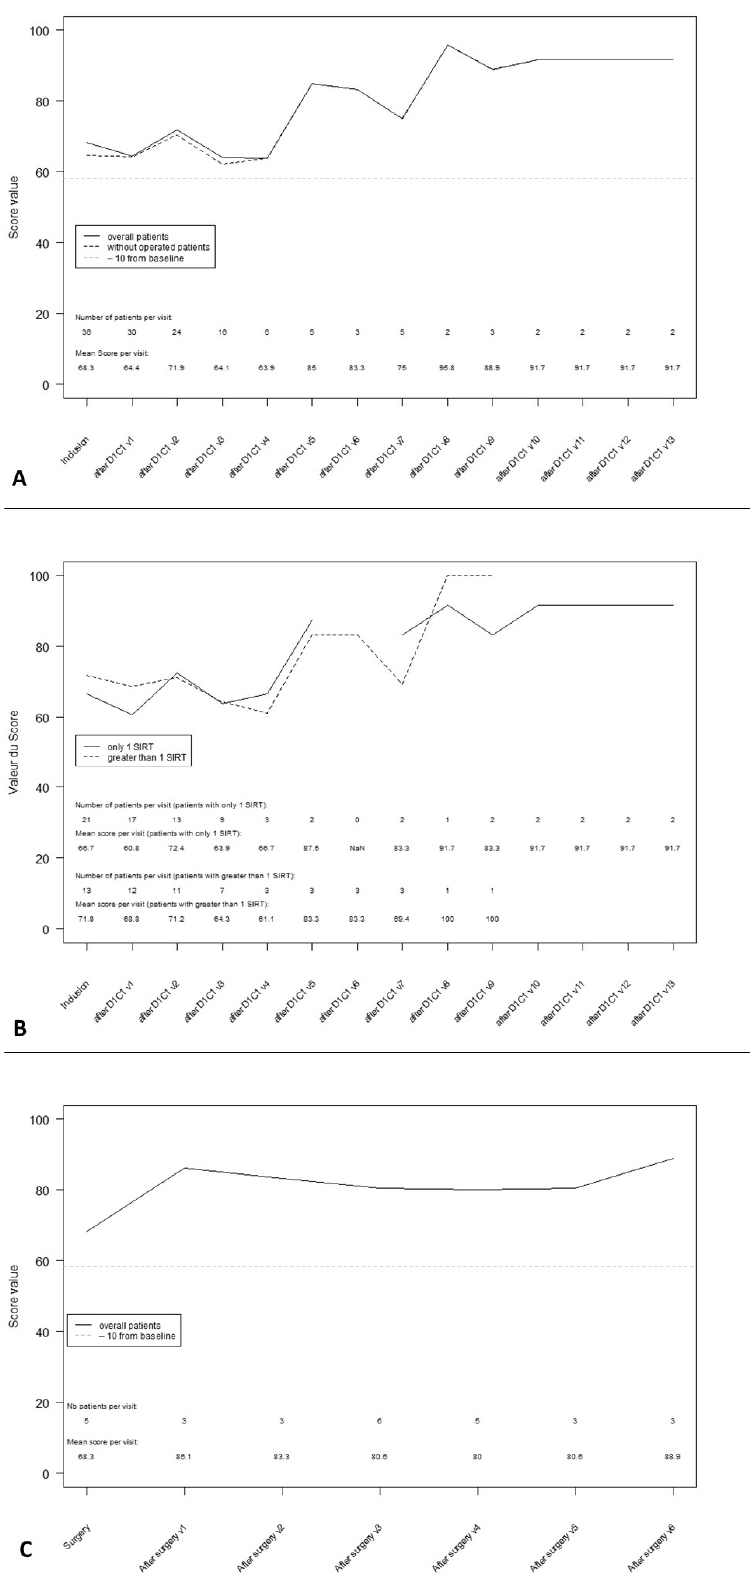
Figure 1. Global health status transformed score during follow-up. ( A ): Global health status score in ITT overall population. ( B ): Global health status score according to the number of SIRT procedures received. ( C ): Global health status score